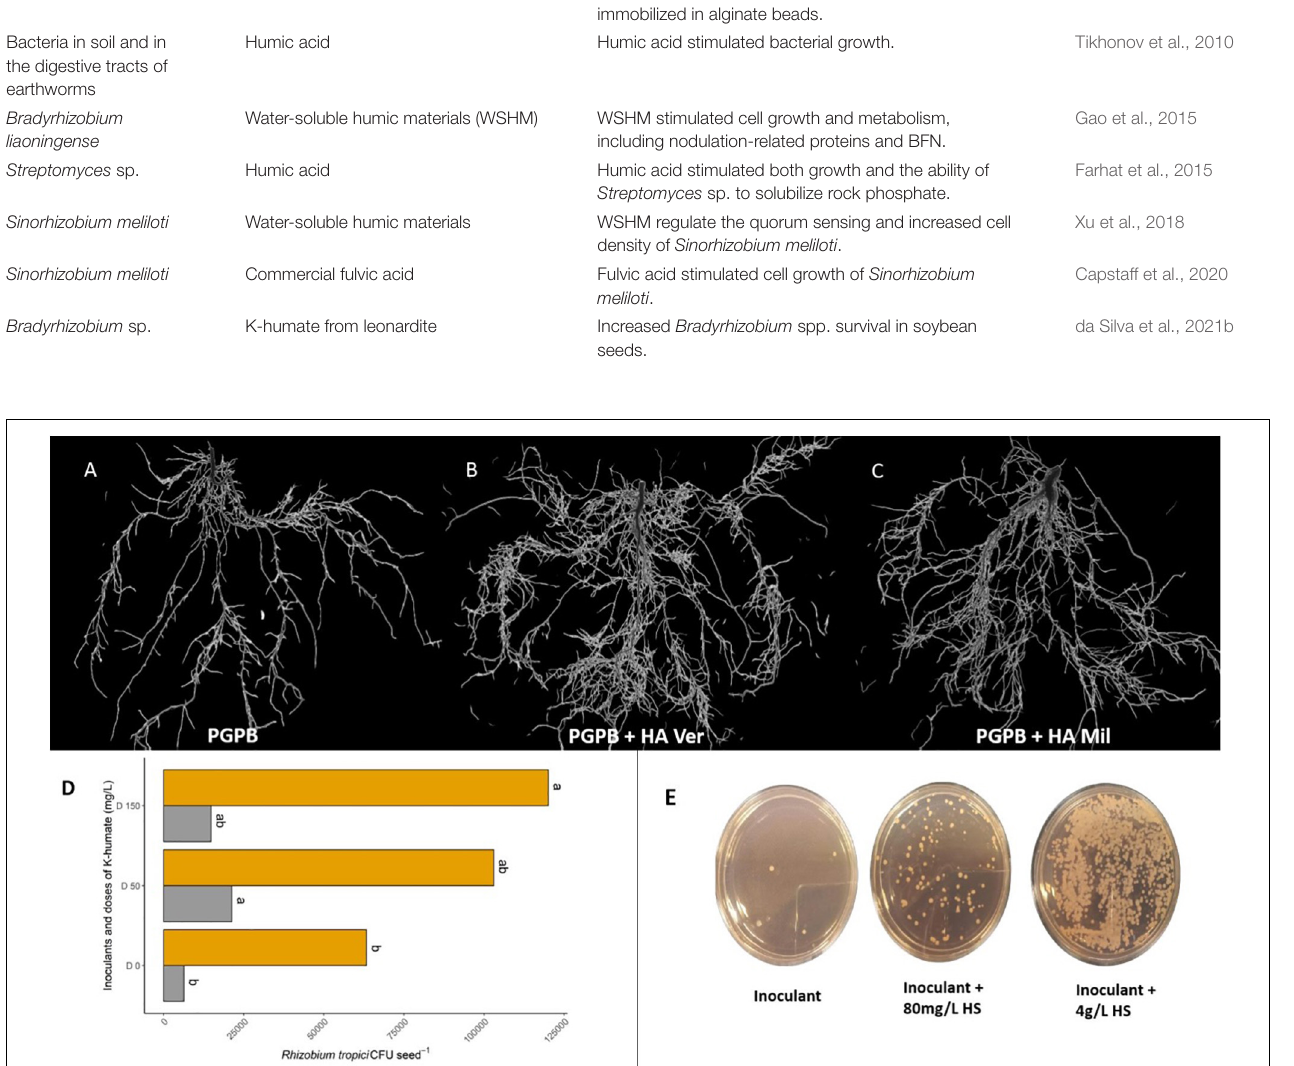
Frontiers in Microbiology |